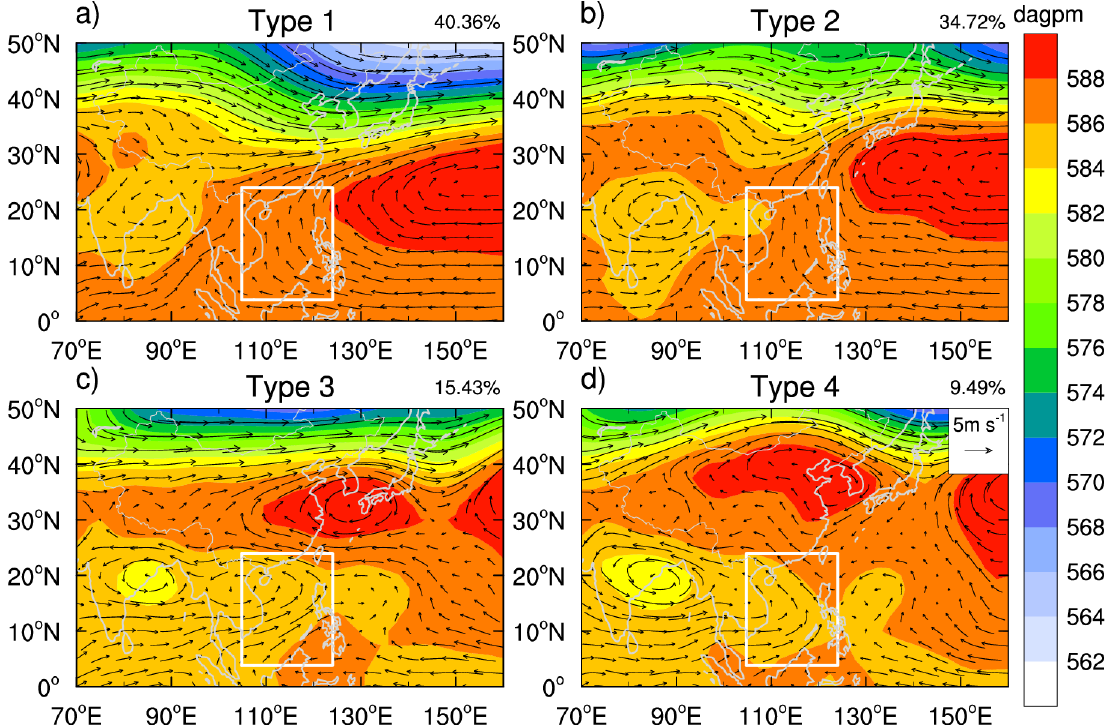
Figure 1. Objective classification of atmospheric circulation for the 500-hPa potential height (shaded, dagpm) and wind field (arrows): ( a ) Type 1; ( b ) Type 2; ( c ) Type 3; ( d ) Type 4.